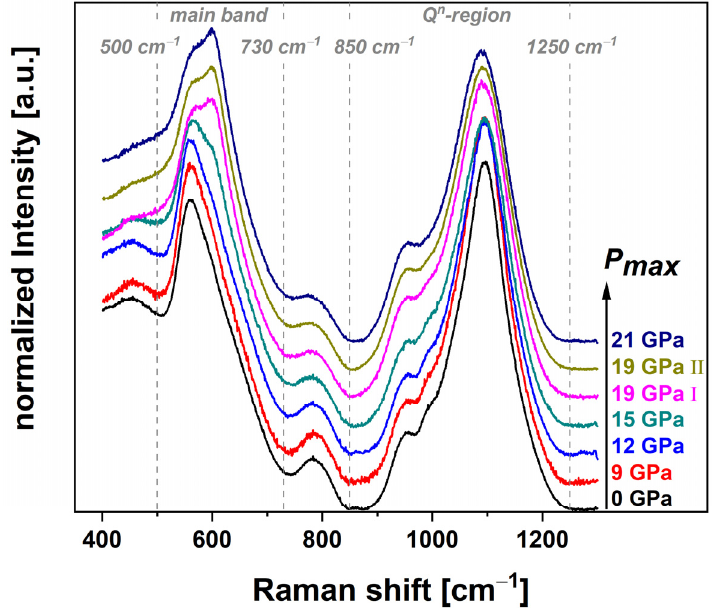
Figure 2. Raman spectra (400 cm − 1 –1300 cm − 1 ) of the densified cylinders with increasing maximum pressure; visible variations of the main band from 500 cm − 1 –730 cm − 1 are related to the evolution of the Si–O–Si inter-tetrahedra angle distribution [9,22]; the Q n -region (850 cm − 1 –1250 cm − 1 ) is assigned to Si–O stretching vibrations [25].